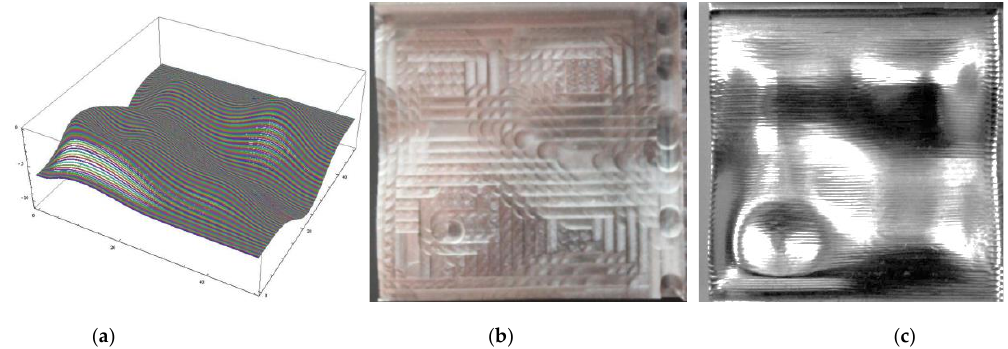
Figure 9. Processing toolpaths ( a ) of an unordered point cloud, ( b ) roughed part and ( c ) the finished part.